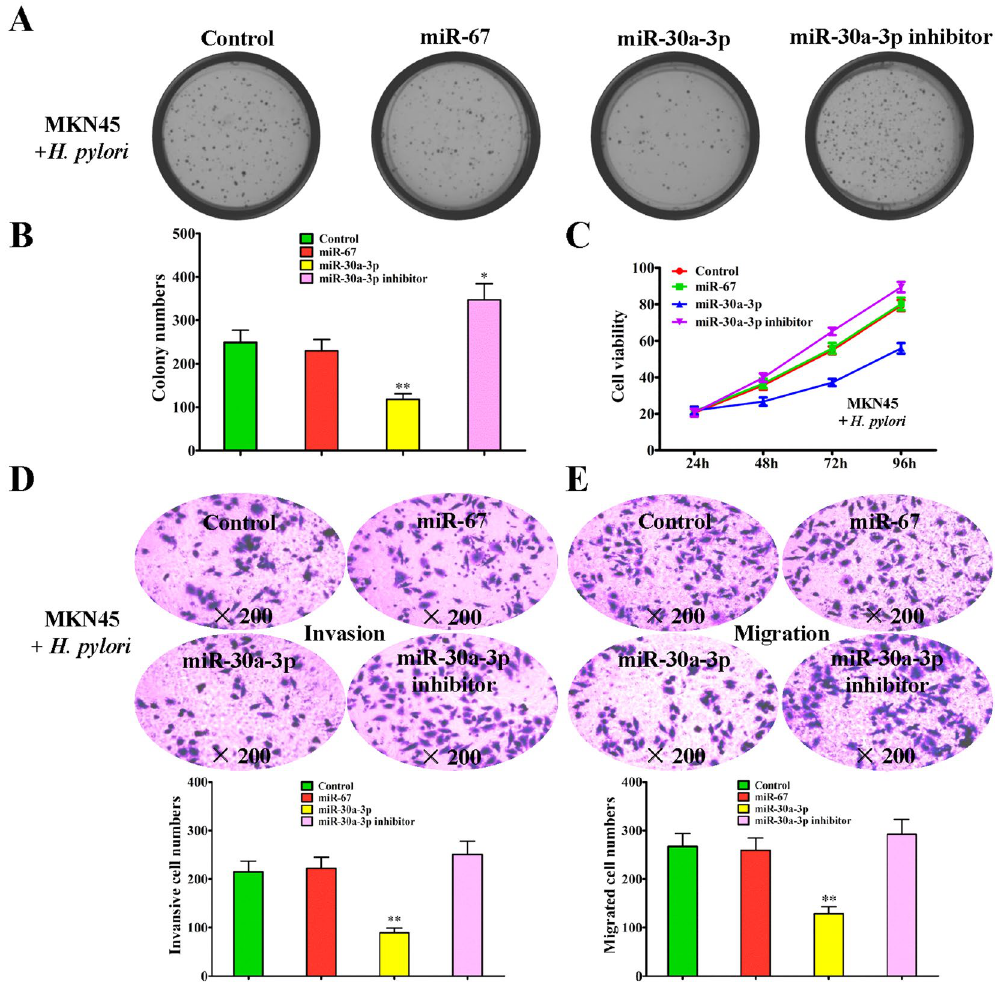
Figure 2. Regulatory effect of miR-30a-3p on the growth and migration of H. pylori -infected gastric cancer cells. ( A ) Colony formation assay of H. pylori -infected MKN45 cells transfected with miR-67 mimic, miR- 30a-3p mimic, and miR-30a-3p inhibitor, respectively. H. pylori -infected MKN45 cells were used as a blank control. ( B ) Quantitative results of the colony formation numbers. ( C ) MTT assay of the cell viability of H. pylori -infected MKN45 cells transfected with miR-67 mimic, miR-30a-3p mimic and miR-30a-3p inhibitor, respectively. H. pylori -infected MKN45 cells were used as a blank control. ( D,E ) Invasion and migration assays of H. pylori -infected MKN45 cells transfected with miR-67 mimic, miR-30a-3p mimic and miR-30a-3p inhibitor, respectively. H. pylori -infected MKN45 cells were used as a blank control Numbers of invasive and migrated cells were shown as mean ± SD, n = 3. ** p < 0.01 by Student’s t test. All the results were reproducible in three independent